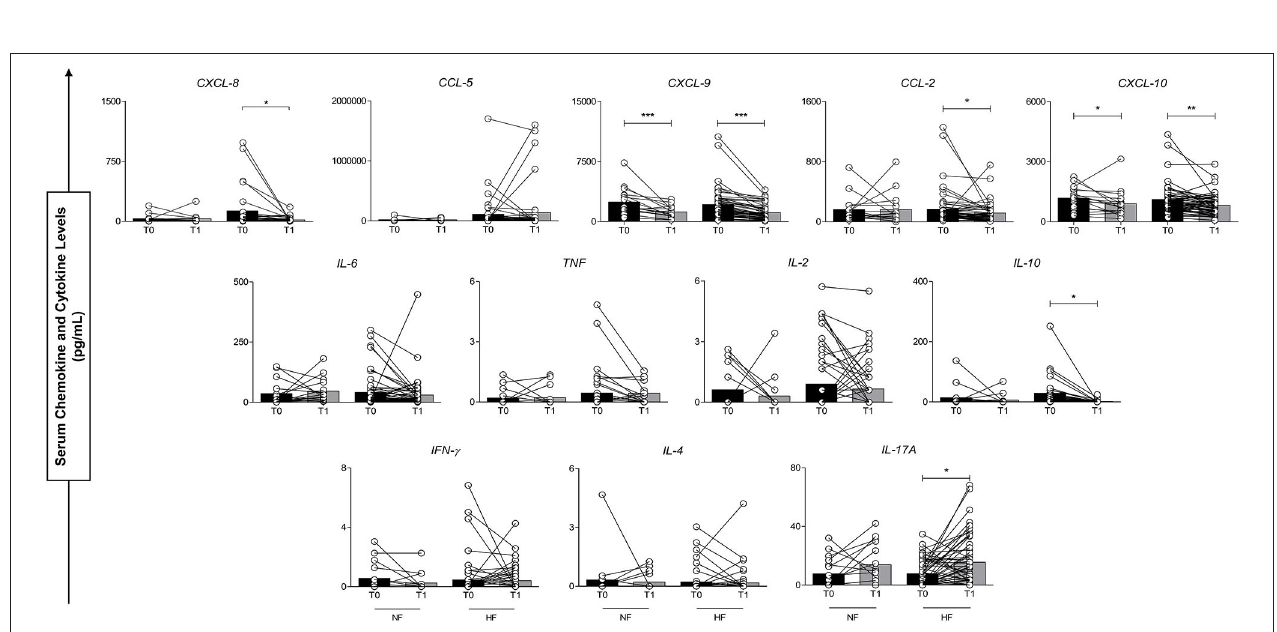
FIGURE 3 | Serum concentrations of circulating molecules of groups with normal fibrinogen (NF) and hypofibrinogenemia (HF) at T0 and T1. * p < 0.05; ** p < 0.01; *** p < 0.0001.